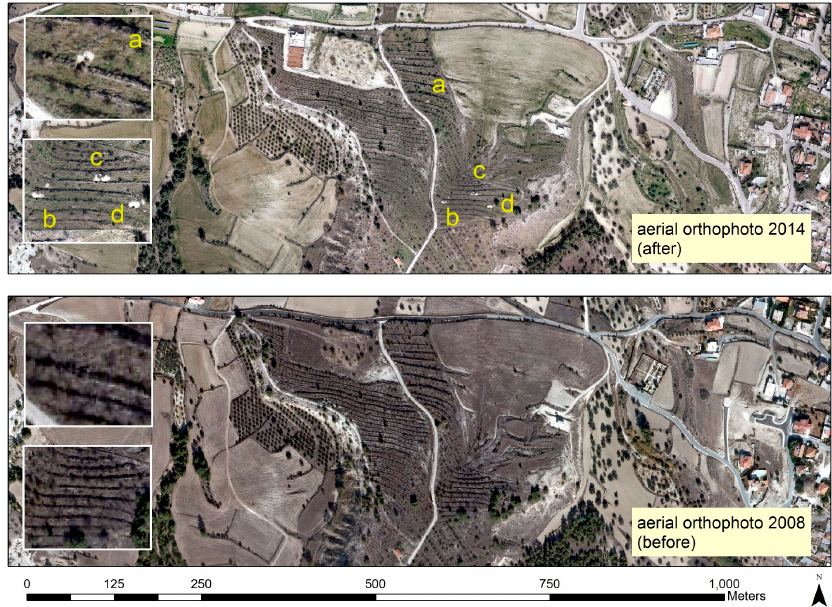
Figure 5. Aerial RGB orthophotos taken in 2008 ( bottom ) and 2014 ( top ). Looted imprints ( a – d ) are traceable only in the latest aerial image.